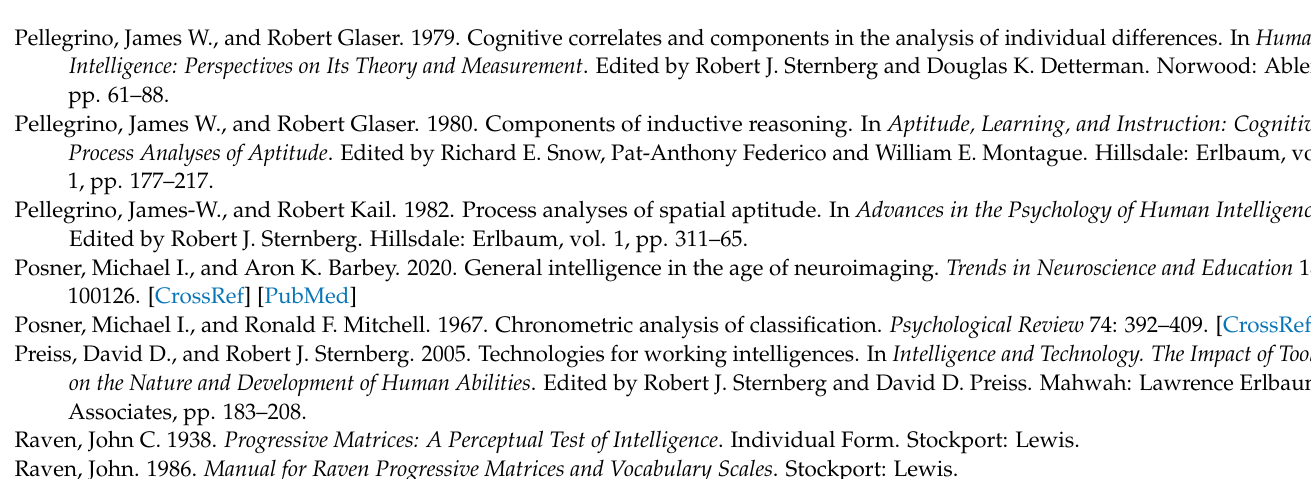
figural matrices in a short video increases test scores. Intelligence 82: 101473.